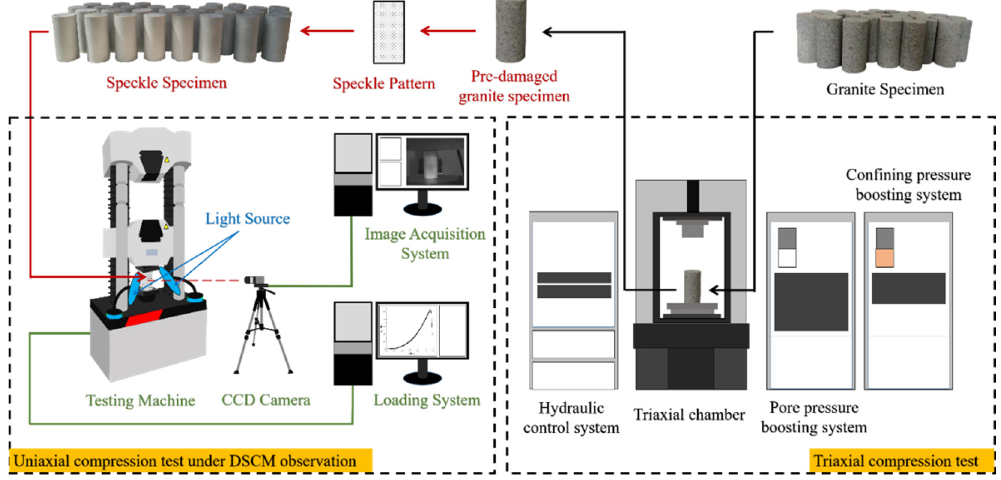
Figure 4. Schematic of experimental scheme.